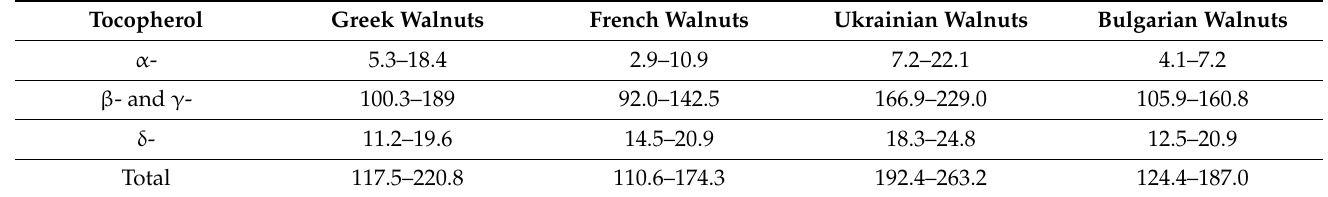
Table 5. Concentration ranges (mg per kg of walnut seed oil) of the samples.